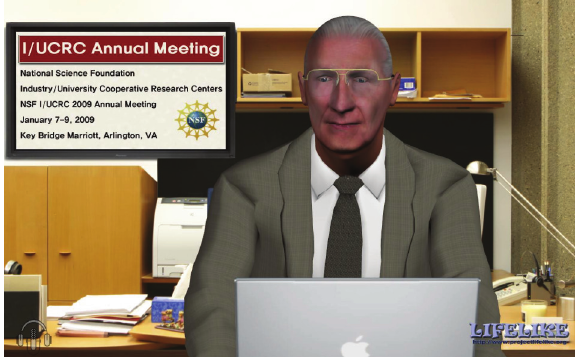
Figure 2. The LifeLike Avatar in its Environment, Ready to Talk to the